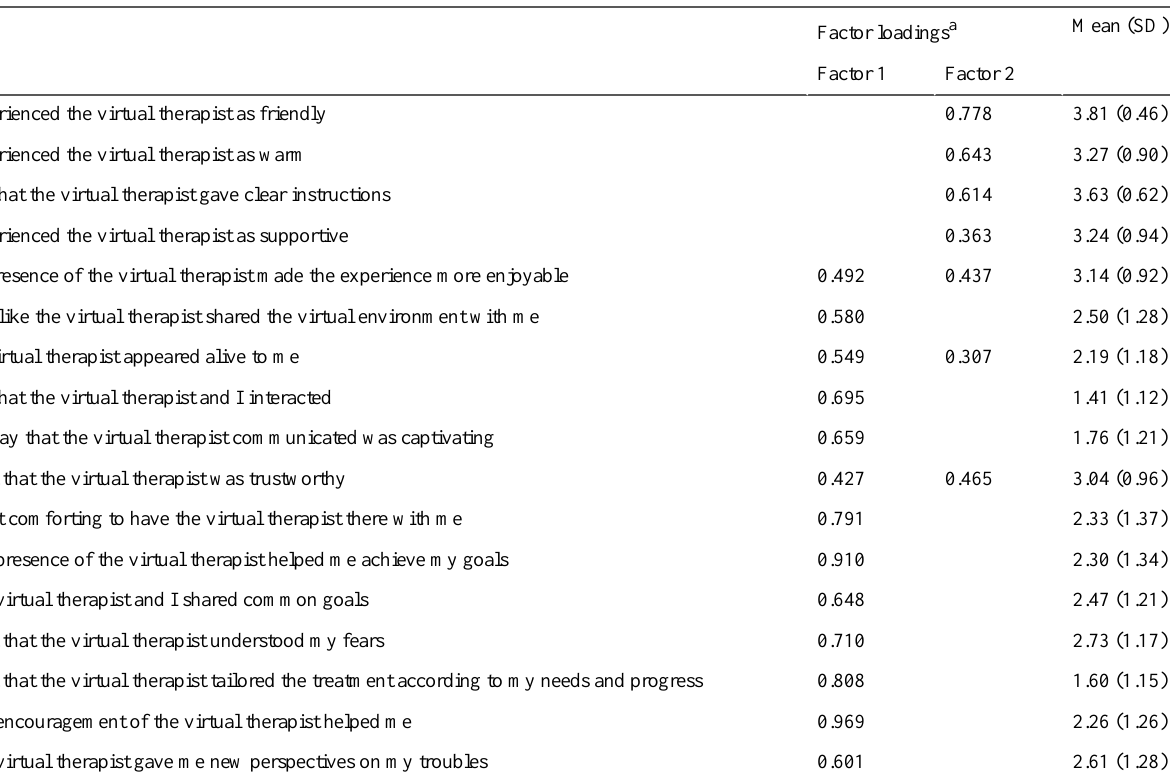
Table 1. Factor loadings for the two factors, including mean item-level